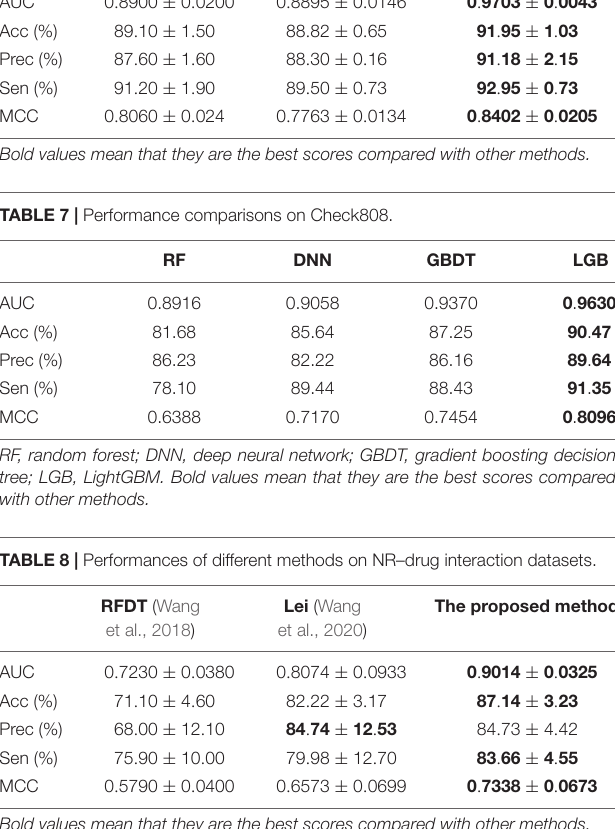
TABLE 6 | Performances of different methods on channel–drug interaction dataset. RFDT (Wang et al., 2018)